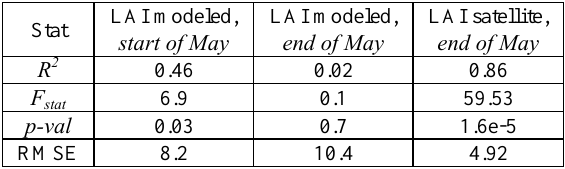
Table 4. Statistical properties of crop yield regression models with model based and satellite predictors at the field